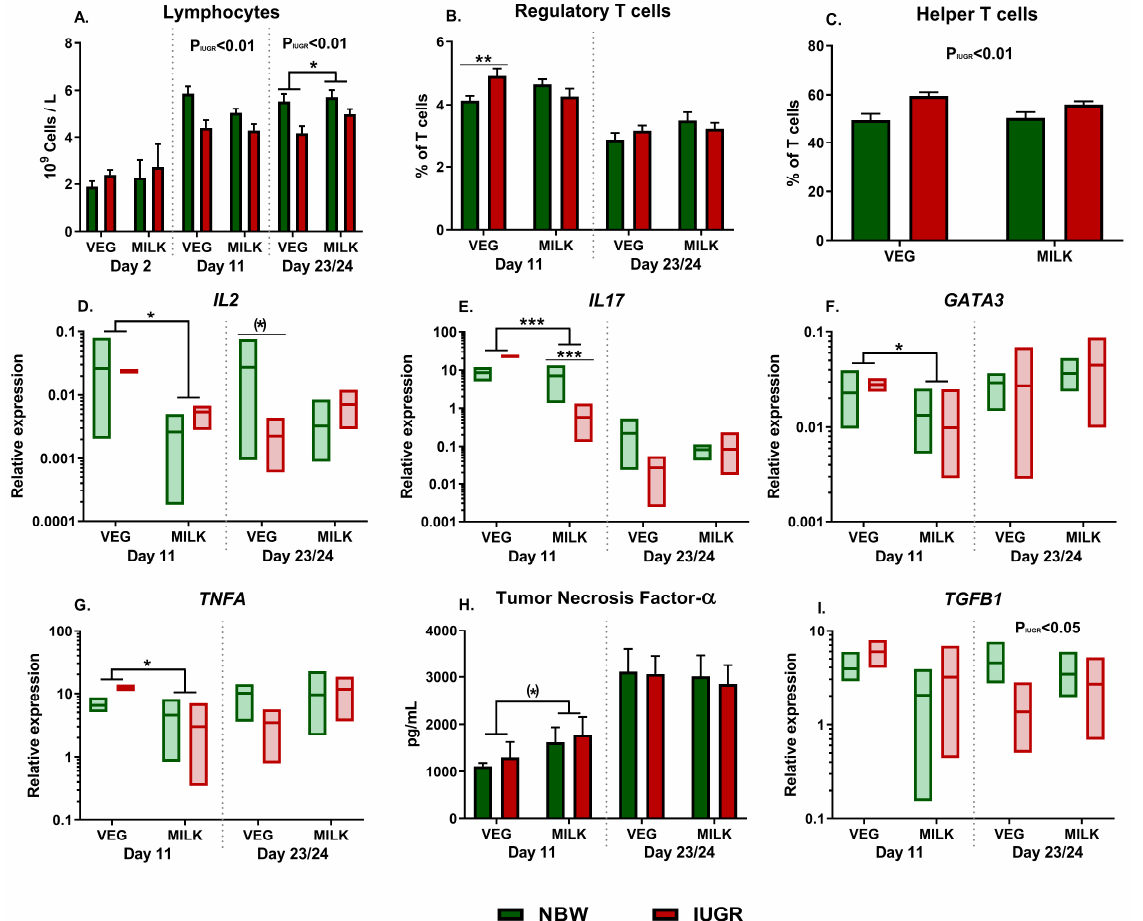
Figure 3. Development of lymphocyte and T cell counts and gene expression of adaptive immune markers in animals fed either vegetable (VEG, n = 6–18) or milk fat (MILK, n = 7–18) further stratified into normal birthweight (NBW, n = 7–18) or intrauterine growth restricted (IUGR, n = 6–18) animals. ( A ) Lymphocyte counts; ( B , C ) Fraction of regulatory and helper T cells; ( D – G , I ) Expression of IL2 , IL17, GATA3, TNFA , and TGFB1 in whole blood stimulated with Staphylococcus epider- midis , shown as relative gene expression; ( H ) Levels of tumor necrosis factor α in samples following stimulation with SE. ( A – C , H ) are presented as means with corresponding standard error. ( D – G , I ) are presented as range plots with corre- sponding medians. *: Effect of diet, ***: P < 0.001, **: P < 0.01, *: P < 0.05, (*): P < 0.1. Main effects of birthweight across diet groups are shown in the figures as P IUGR. 3.4. Cellular Metabolism Expression of genes related to energy metabolism was investigated in whole blood samples stimulated with SE. On day 11, there were interactions between diet and birth- weight on the expression of PPARG and PDHA1 (both P < 0.05) with post hoc tests in both cases indicating lower expression in MILK-IUGR than MILK-NBW ( P < 0.01, P < 0.001, Figure 4A,B). Likewise, expression of PPARG , PDHA1 , and PKM was lower in MILK than VEG pigs (all P < 0.05 FC, Figure 4A–C). By day 23/24, compared to NBW, the IUGR ani- mals showed a lower expression of PPARG ( P < 0.05, Figure 4C)